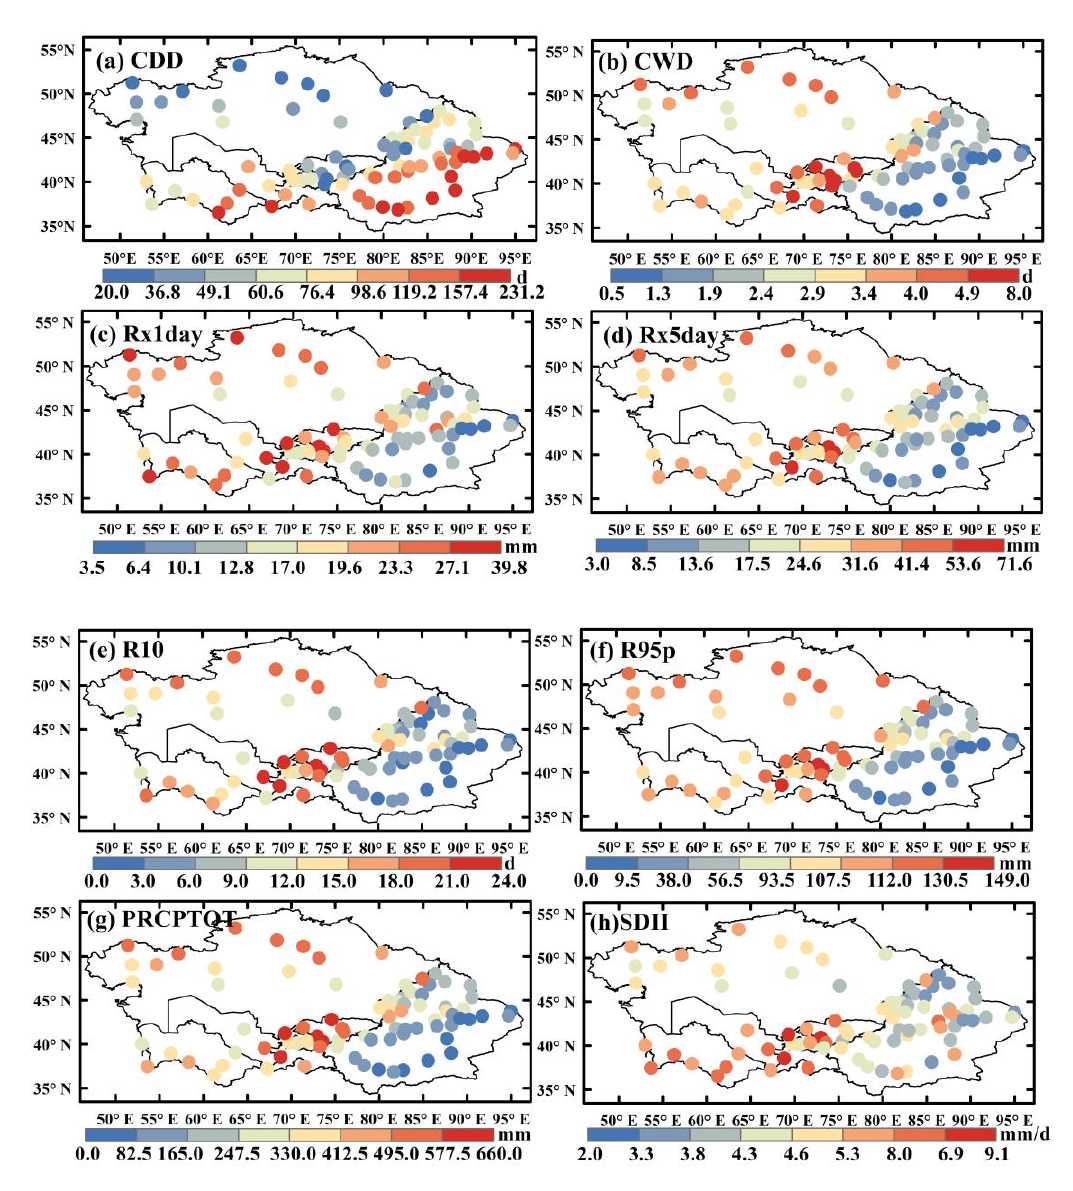
Figure 3. Geographical distribution of multi-year average of eight precipitation indices at 84 stations in CA during 1979–2005: ( a ) CDDs; ( b ) CWDs; ( c ) Rx1day; ( d ) Rx5day; ( e ) R10; ( f ) R95P; ( g ) PRCPTOT; ( h ) SDII.